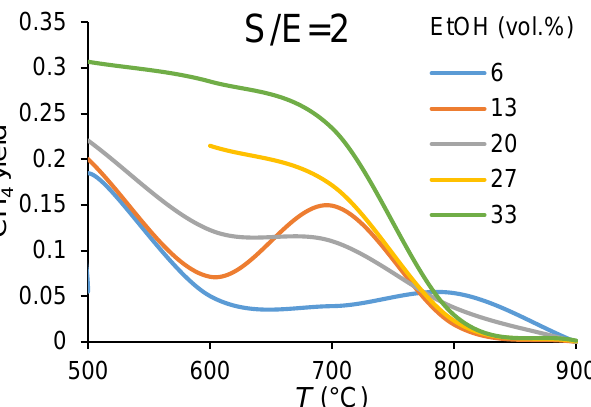
Figure 6. Temperature dependencies of methane yield in ethanol steam reforming in CMR at the different ethanol concentrations (in vol.%) and the steam-to-ethanol molar ratios in the feed.